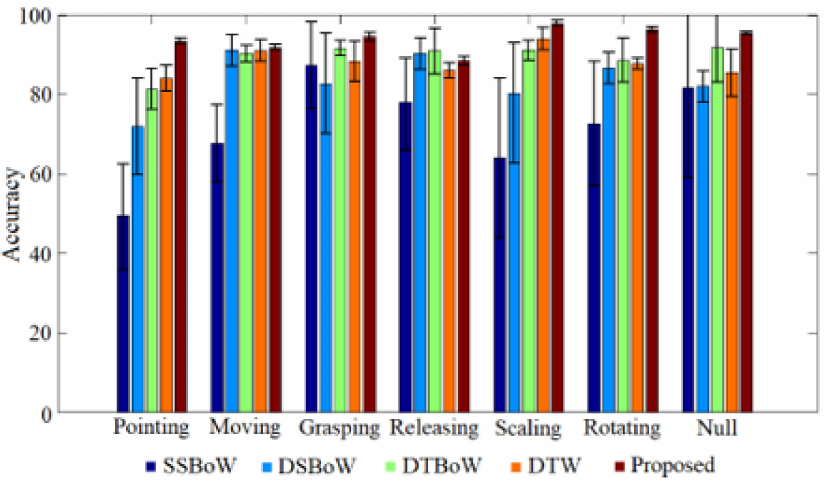
Figure 15. Accuracy of frames recognition in an action unit on HoloLens ARAAT dataset.